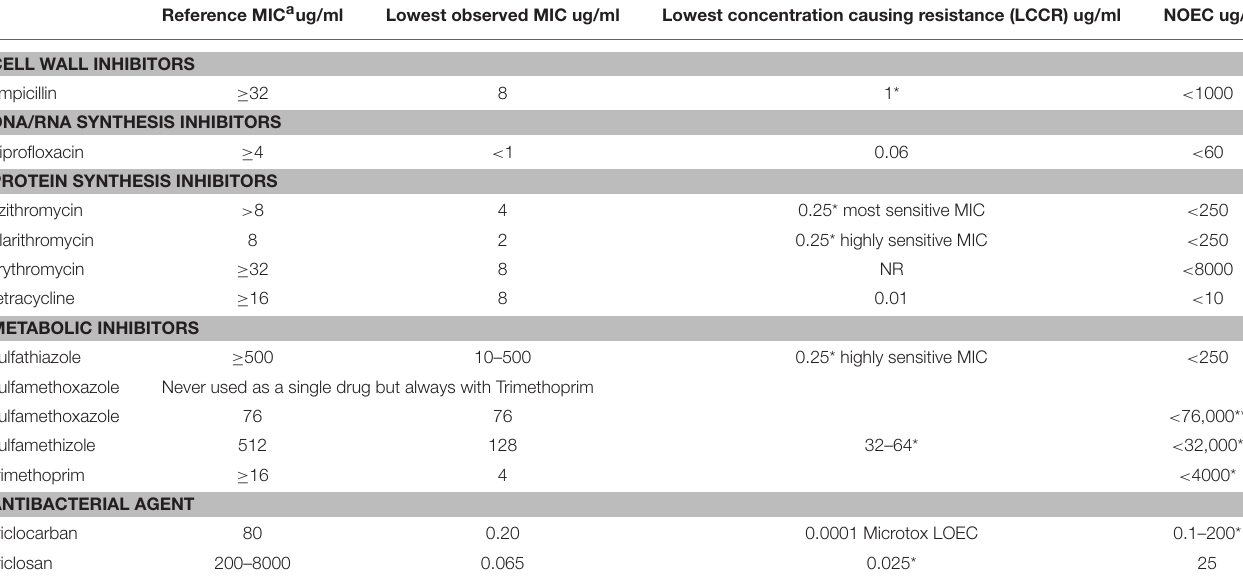
TABLE 6 | MIC and screening level assessment values for 10 antibiotics and two antibacterial agents frequently detected in the environment. Reference MIC a